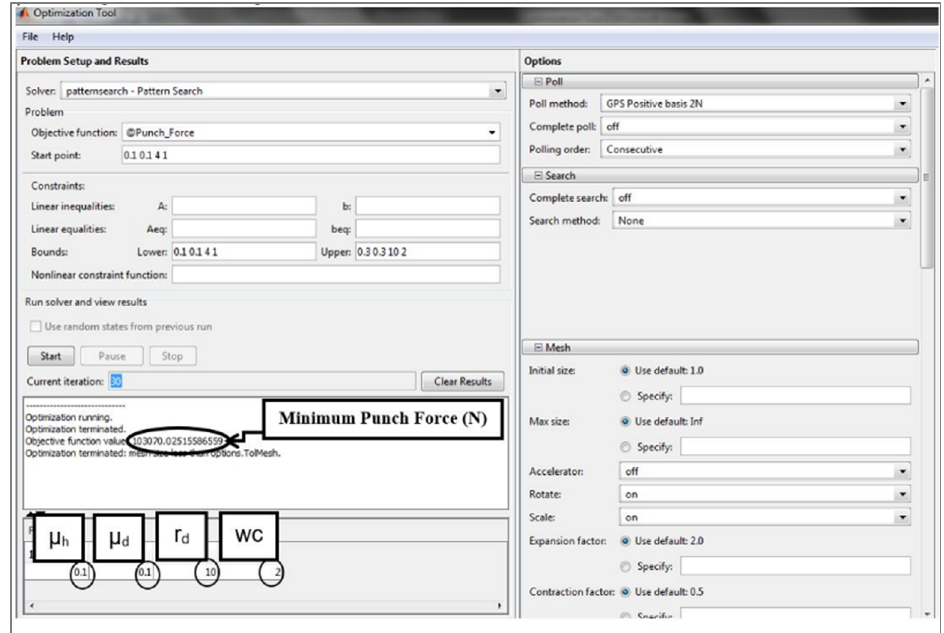
Figure 11. Screenshot of optimization tool used in current work.